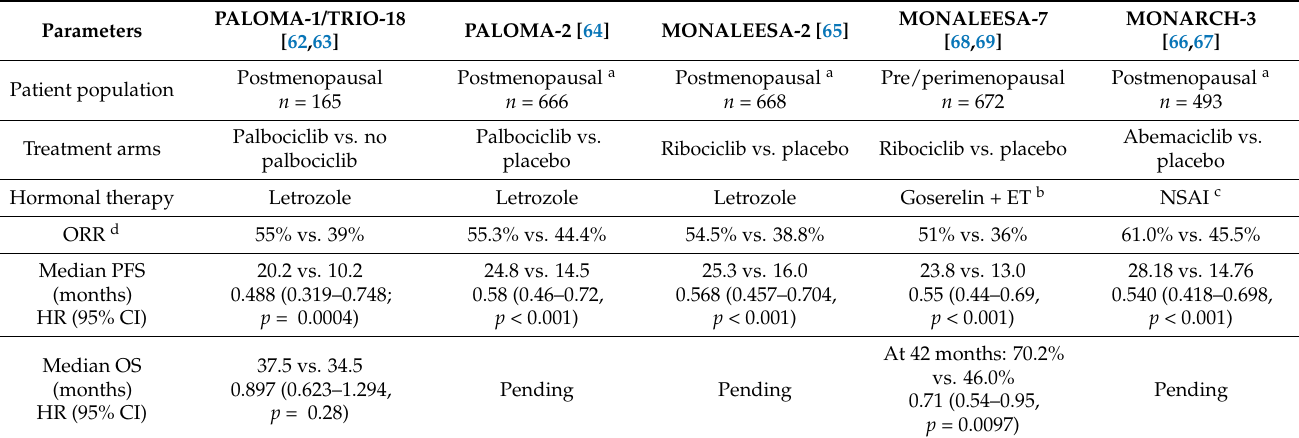
Table 3. Clinical data of CDK 4/6 inhibitors with an aromatase inhibitor as first line treatment for women with HR+ advanced breast cancer.